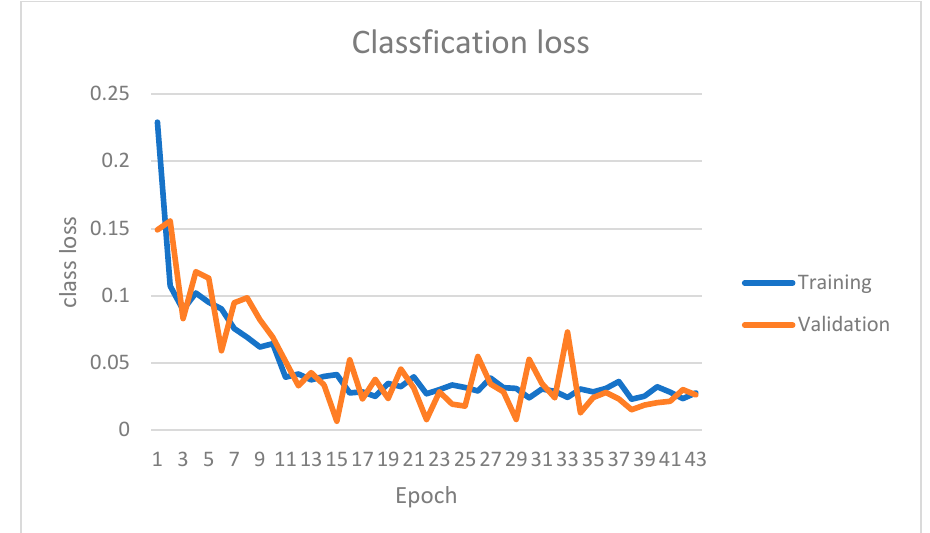
Figure 9. Instance segmentation classification loss on both training and validation datasets over different epochs.